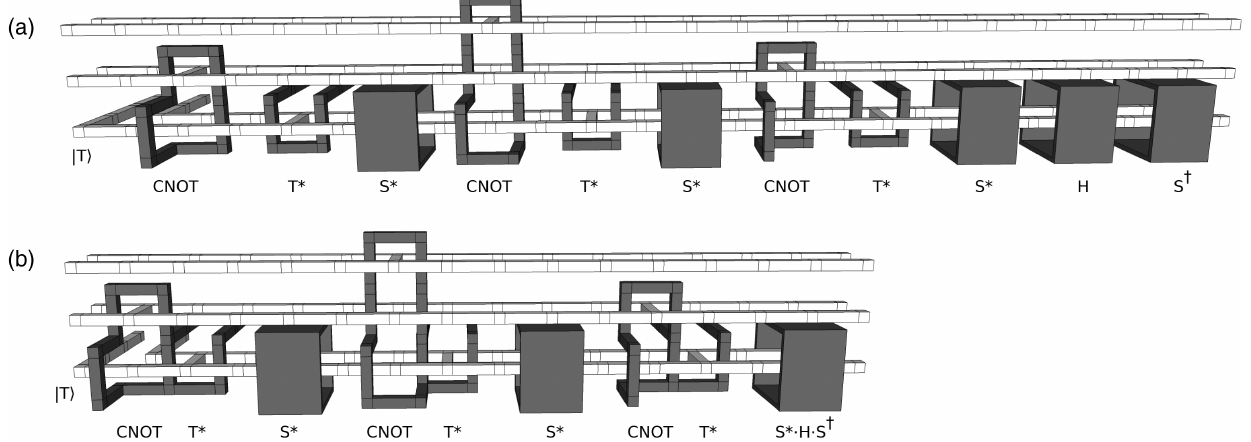
FIG. 21. (a) Canonical surface code AND gate computation (Fig. 4) circuit. The bottom pair of white lines (coming from the back instead of from the left) represents the injection of a j T i state. Each dark ring is a CNOT . Each dark U-shape labeled T* is a random T or T † gate (as determined by a measurement in a location not shown in the diagram connecting to the dark U-shape). The boxes labeled S* immediately following each T* are S or S † gates that are included if the random T or T † gate results in the incorrect gate. The final two boxes are Hadamard and S † operations, respectively. (b) Compressed version. The final three boxes can be compressed to a single box, as an arbitrary single-qubit Clifford can be performed inside using twists [104] and other techniques [105]. Distinct dark structures can be made to touch, provided this occurs in a single place [36].